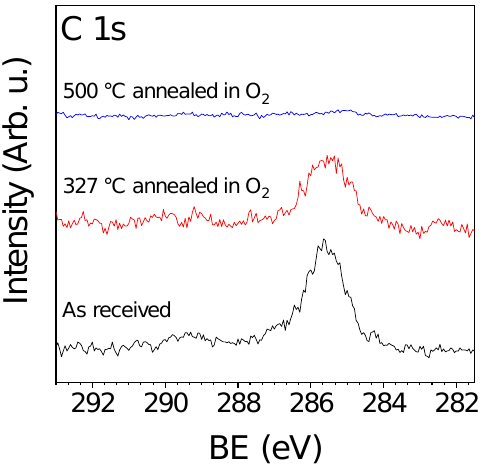
Figure 4. NAP-XPS spectra of the C 1s core-level acquired from the as-received ZnO NRs, after annealing in 5 mbar O 2 at 327 °C and after annealing in 5 mbar O 2 at 500 °C.